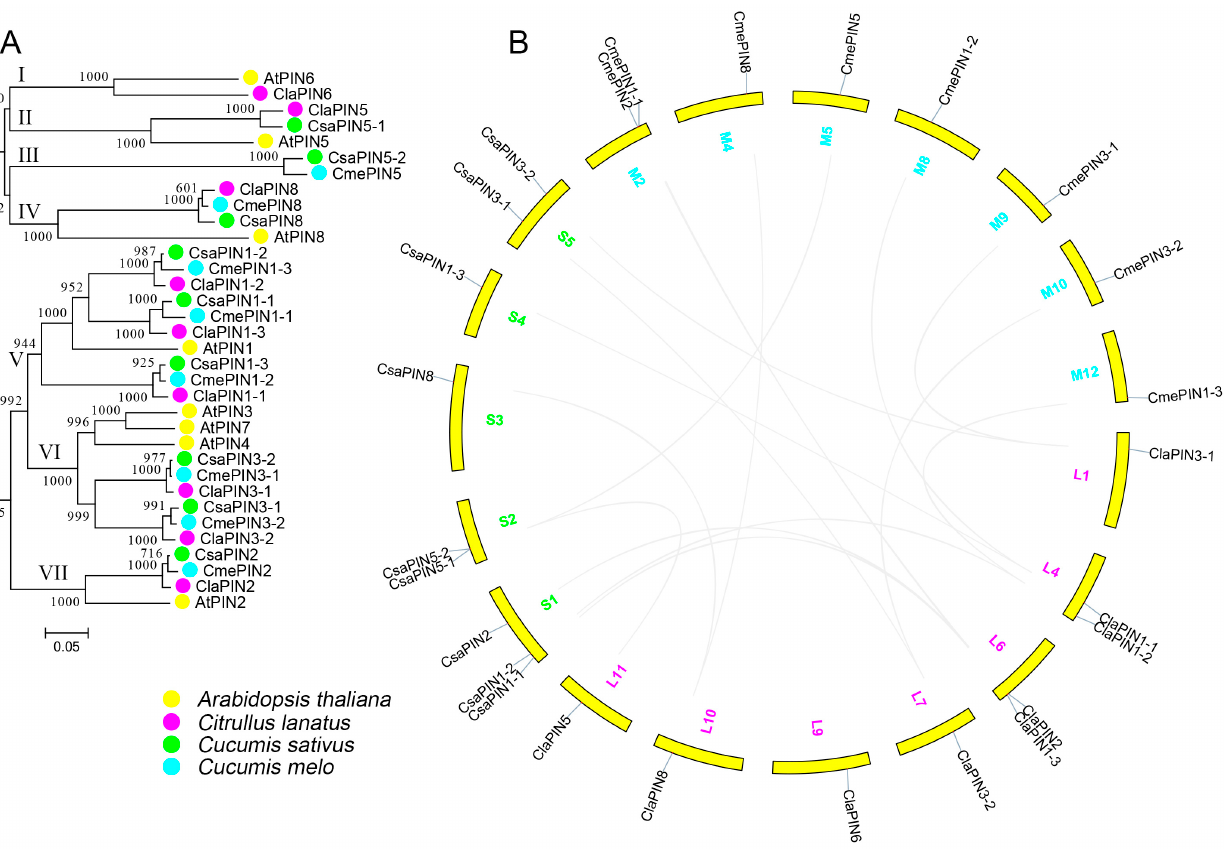
Figure 1. Phylogenetic ( A ) and chromosomal localization ( B ) of the Cucurbitaceae PIN family. The proteins from Arabidopsis thaliana , cucumber, melon and watermelon are shown in yellow, blue, green, and pink, respectively ( A ). The chromosome numbers are listed beside chromosomes (yellow) for watermelon (pink), cucumber (blue), and melon (green), respectively. The homologous gene pairs are connected with grey solid lines.